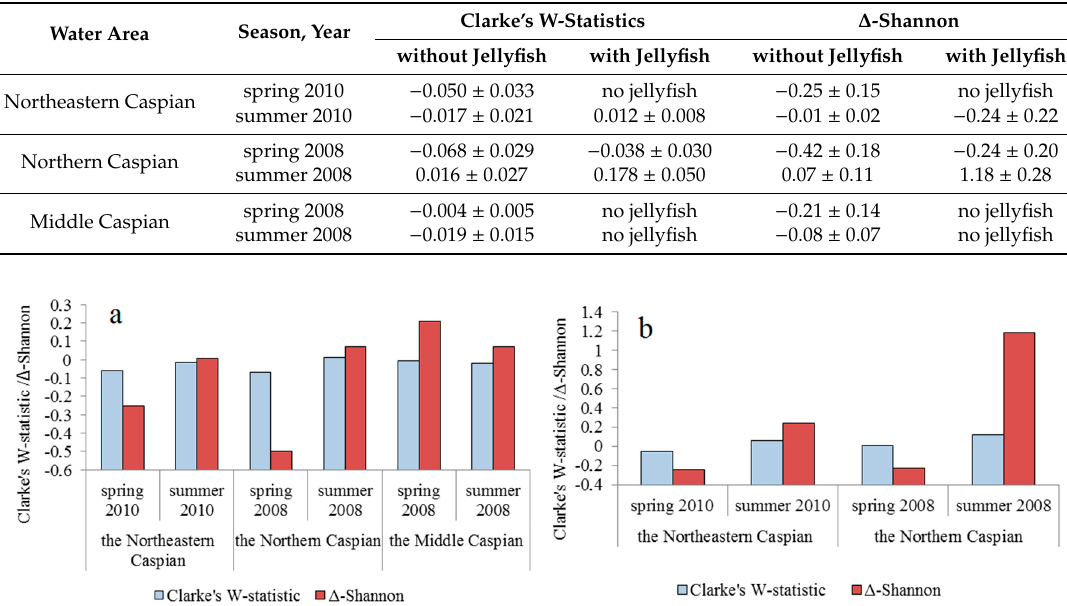
Table 7. Evaluation of seasonal changes in the structure of zooplankton communities in the surveyed areas of the Caspian Sea according to Student’s t -test, p < 0.05.